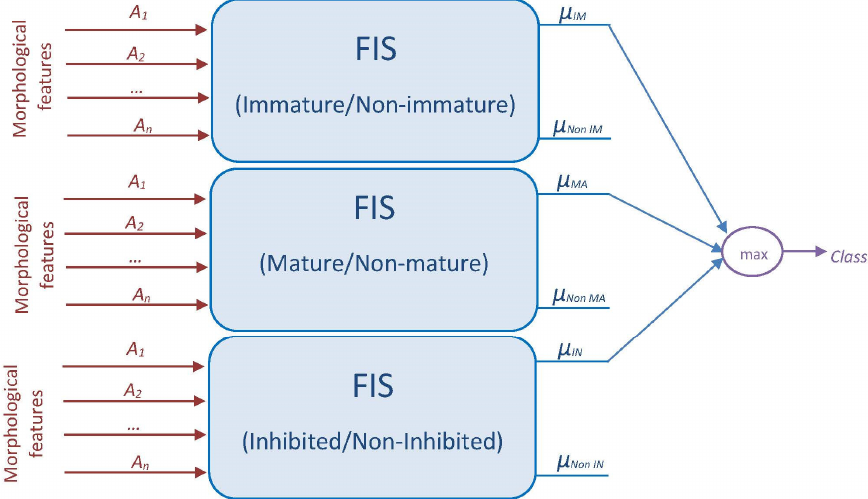
Figure 6. Flowchart of the proposed FIS2 system for fuzzy DCs classification.